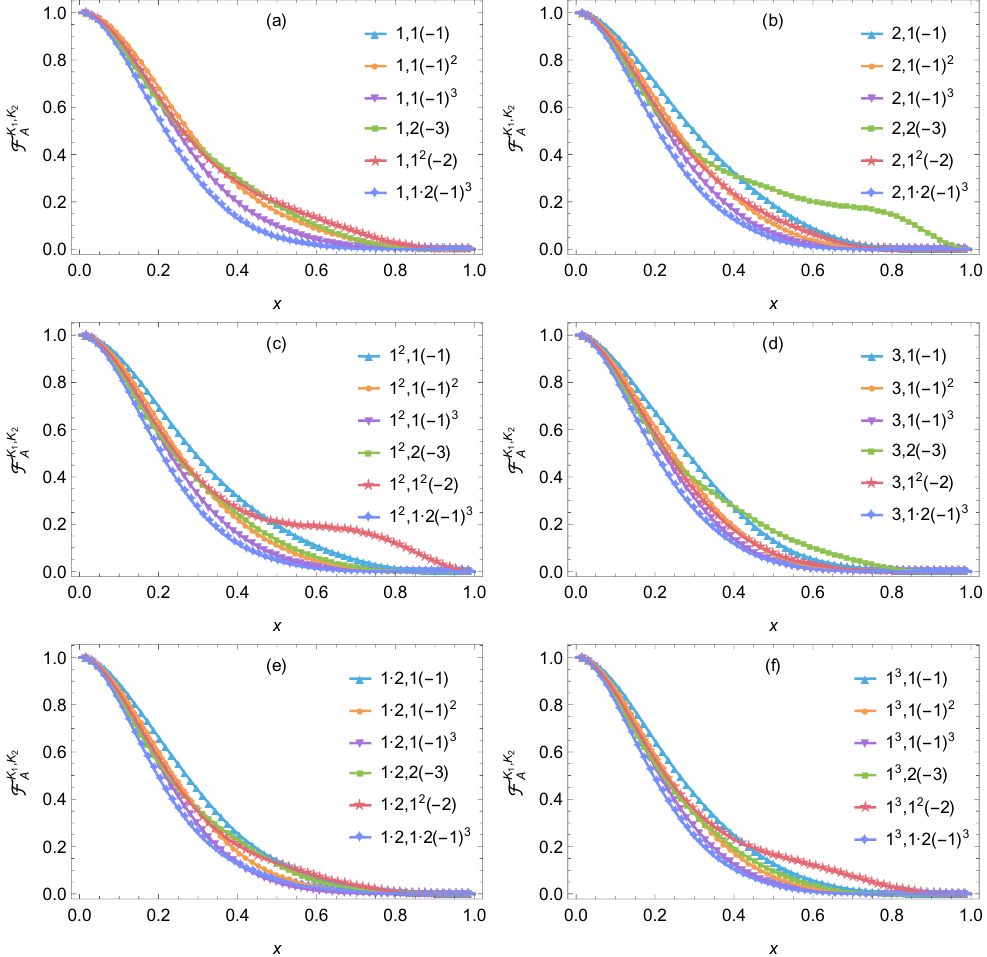
¯ X Figure 5 . The product F X 1 , X 2 in the 2D free massless non-compact bosonic theory (lines) and 3 A the corresponding quantities in the gapless limit of the harmonic chain (symbols). We have set m = 10 − 5 , L = 64